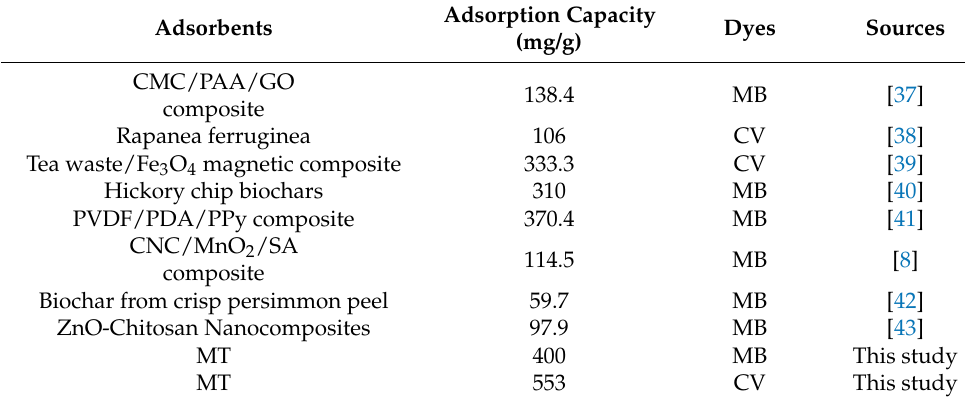
Table 4. Comparison of adsorption capacity of different adsorbents for MB and CV.